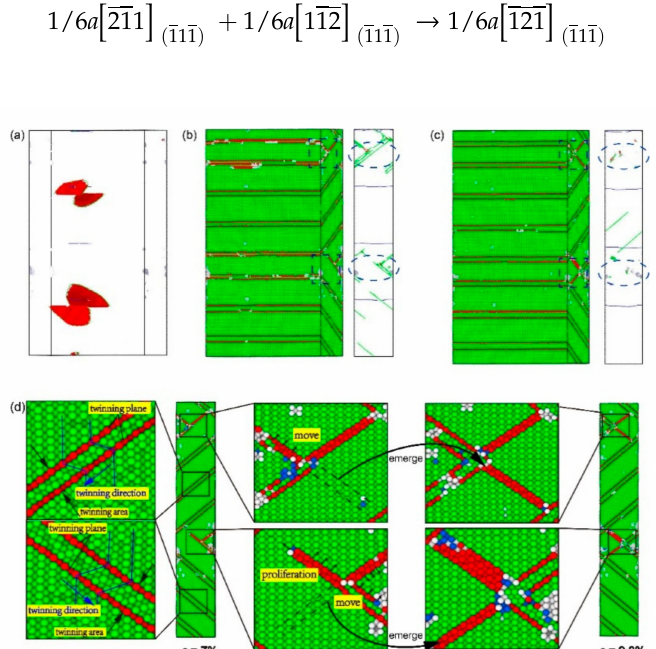
Figure 13. The common neighbor analysis (CNA) and dislocation analysis (DXA) of the model with α = 90 ◦ under di ff erent strains ε : ( a ) ε = 6.1%, ( b ) ε = 7%, and ( c ) ε = 9.8%; and ( d ) the microscopic structure of the model with α = 90 ◦ under ε = 7% and ε = 9.8%.